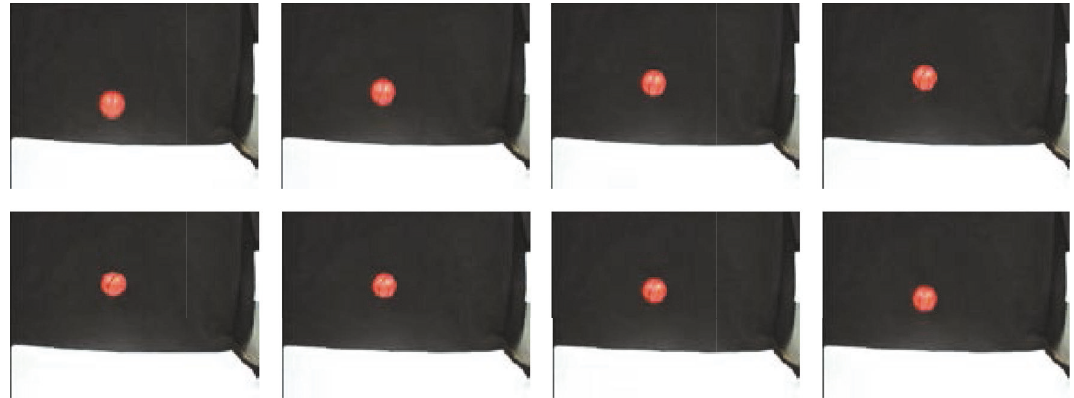
Figure 11: The tested image